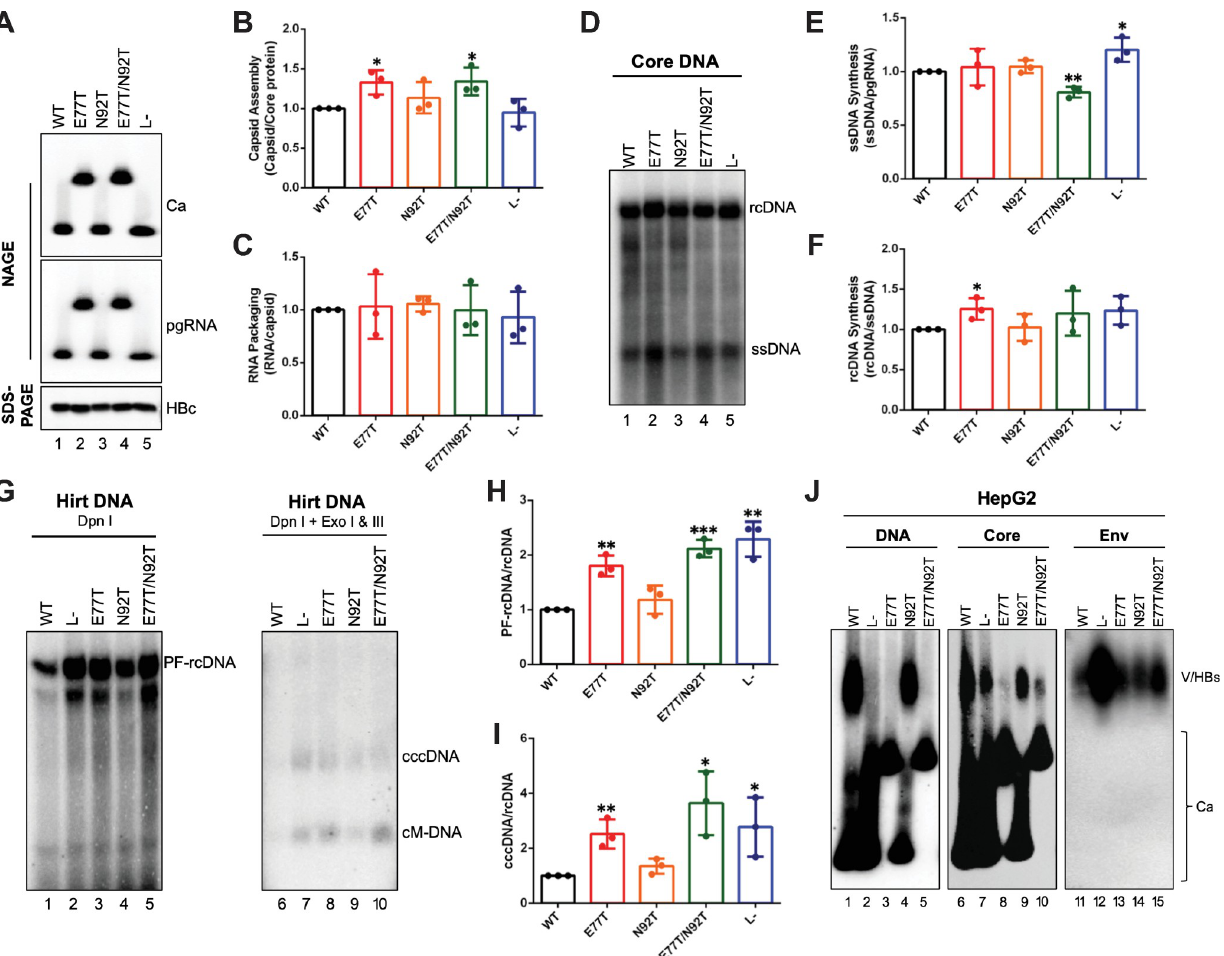
Fig 4. Effects of introducing N-glycosylation sequons on HBc functions. The HBV replicon construct expressing the E77T, N92T, or E77T/N92T mutant HBc, or WT HBc, or L - that is defective in L-HBs expression was transfected into HepG2 cells. (A) The assembled capsids (top) and packaged pgRNA (middle) were detected by the T2221 anti-HBV precore/core NTD mAb and anti-sense HBV RNA probe, respectively, following the resolution of cytoplasmic lysates by NAGE and transfer to nitrocellulose membrane. Levels of HBc proteins (bottom) were measured by western blot using T2221 mAb after SDS-PAGE. Quantitative results of capsid assembly efficiency (B) and pgRNA packaging efficiency (C) were obtained as described in Fig 3 and are shown. (D) HBV core DNA was released from the NCs of cytoplasmic lysate by SDS-proteinase K treatment and detected by Southern blot analysis. The ssDNA synthesis efficiency (E) was determined by normalizing the levels of ssDNA to those of pgRNA in ( A ), and the rcDNA synthesis efficiency (F) was determined by normalizing the levels of rcDNA to those of ssDNA in (D) , with the efficiencies of WT HBc set to 1.0. (G) HBV PF-DNA was extracted from the transfected cells by the Hirt extraction method. The extracted DNA was treated with Dpn I (left) or Dpn I plus Exo I & III (right) to remove all DNA with free 3’ ends. The PF-rcDNA synthesis efficiency (H) was determined by normalizing the levels of PF-rcDNA to those of rcDNA in (D) , and cccDNA formation efficiency (I) was determined by normalizing the levels of cccDNA to those of rcDNA in (D) , with the efficiencies of WT HBc set to 1.0. (J) Culture supernatant from HBV replicon transfected HepG2 cells was harvested at day 5 post transfection, concentrated (50X), resolved by agarose gel electrophoresis and transferred to nitrocellulose membrane. HBV DNA, capsids in virions, and envelope proteins in virions and subviral particles were detected sequentially using a 32 P-labeled HBV DNA probe, anti-HBV precore/core NTD mAb T2221, and anti-HBs polyclonal antibody, respectively, on the same membrane. Data is shown as mean ± SD. Two-tailed unpaired Student’s t test was used to compare the difference of each dataset versus WT HBc ( � , p < 0.05; �� , p < 0.01; ��� , p < 0.001). Ca, capsid; pgRNA, pregenomic RNA; HBc, HBV core protein; ssDNA, single-strand DNA; rcDNA, relaxed circular DNA; cccDNA, covalently closed circular DNA; cM-DNA, closed minus strand DNA; Ca, capsid; V, virion; HBs, HBV surface